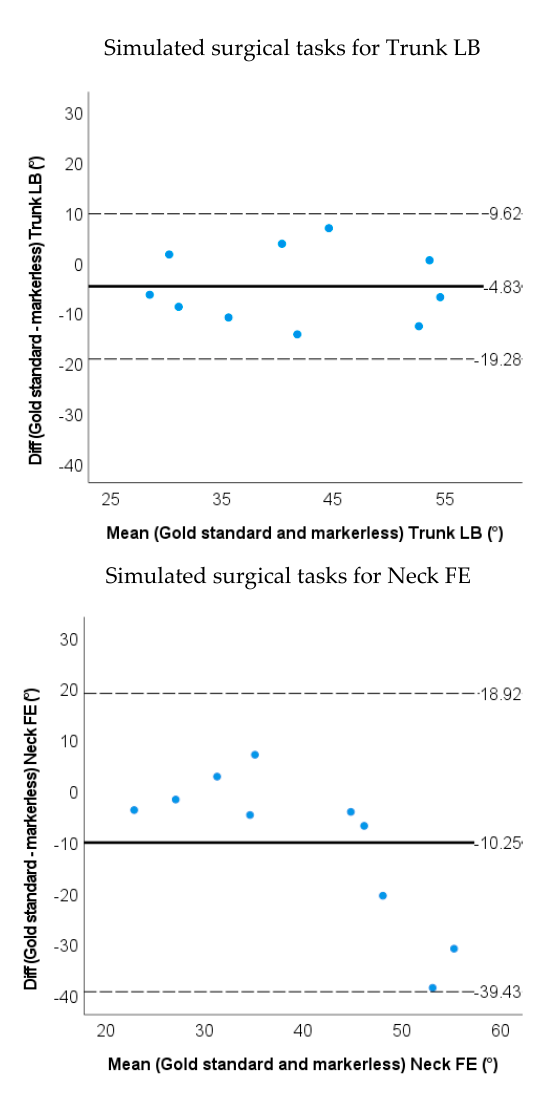
Figure 9. Bland − Altman plots for the ROM of the trunk and neck angle obtained by the gold stand- ard and markerless method for SP-movements. The solid line represents the mean difference, and the dashed line represents the 95% limits of agreement.